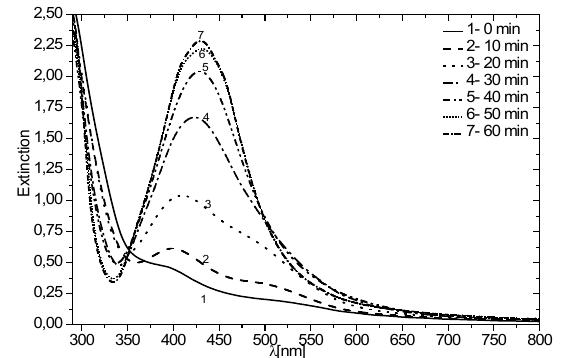
Figure 7. UV-Vis spectra of silver nanoparticles recorded during the photoreduction of AgBr nanoparticles in the presence of ascorbic acid – characteristic reaction.